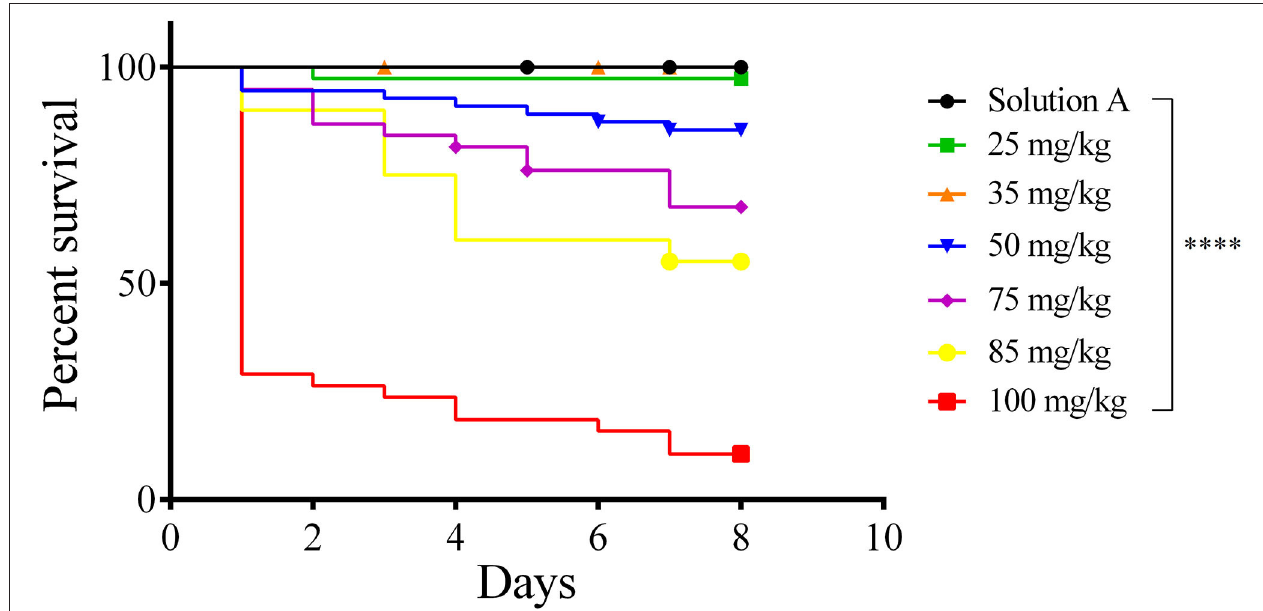
FIGURE 2 | Survival curve (Kaplan–Meier and Mantel Cox). Toxicity of AgNP in Galleria mellonella . Groups of 18 larvae each were treated with 25–100 mg/Kg of larvae tissue. The control groups were Solution A (black line) and Sham (not shown). Larvae were incubated at 37 ℃ and their viability was followed for 8 days. Each line represents the mean of three independent experiments. **** p <